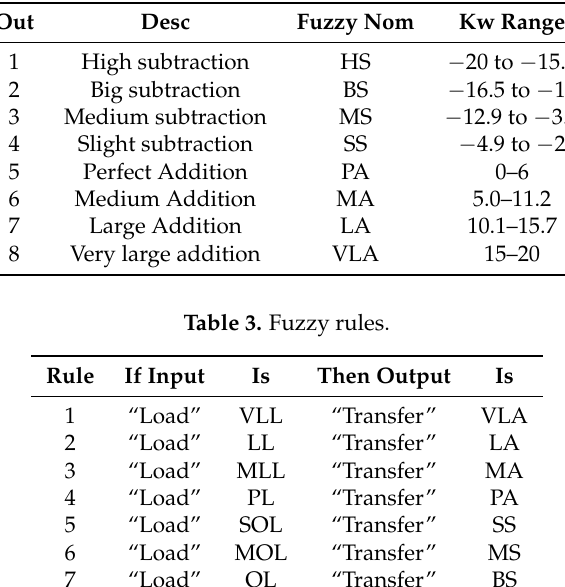
Table 2. Output fuzzy nomenclature.